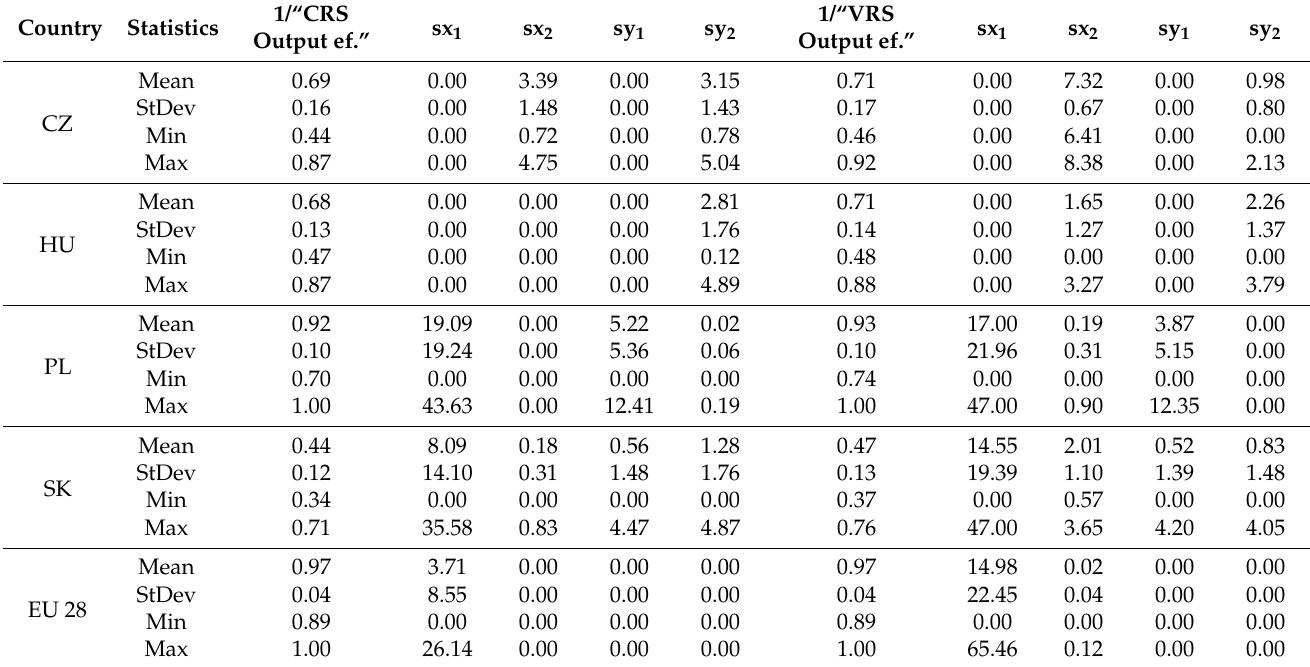
Table 3. Results of DEA, CRSand VRS efficiencies of V4 compared to EU 28